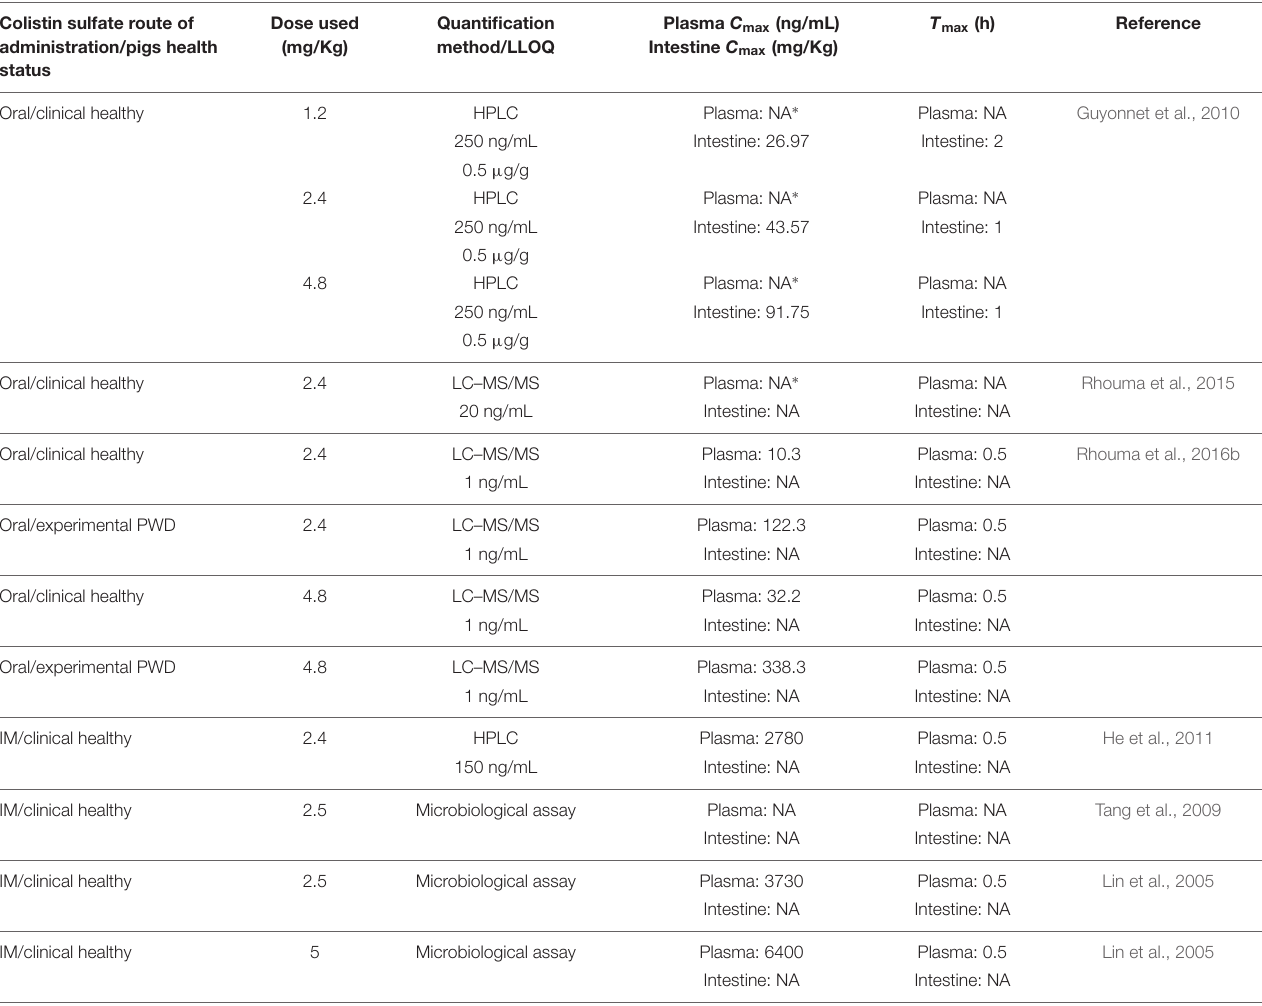
TABLE 1 | Colistin sulfate PK data in pigs following its oral or intramuscular administration. Colistin sulfate route of administration/pigs